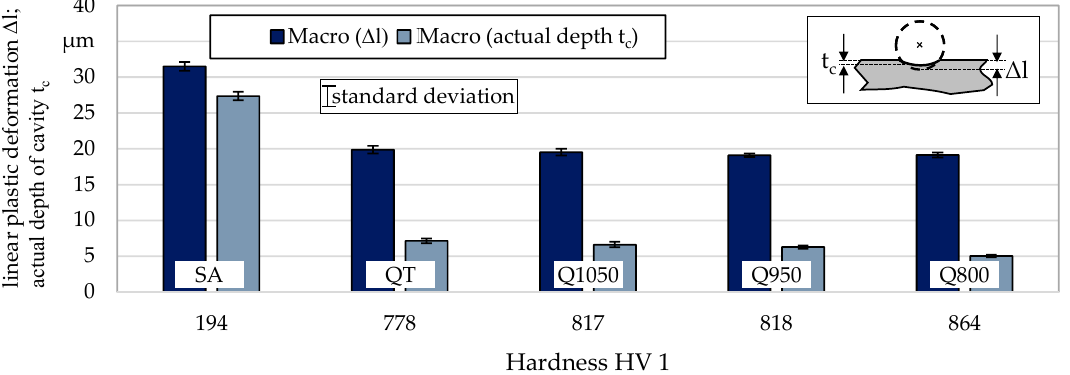
Figure 7. Comparison of the linear plastic deformation and the actual depth of the cavity determined for the macroscopic samples (single-impact peening; n ≥ 5).